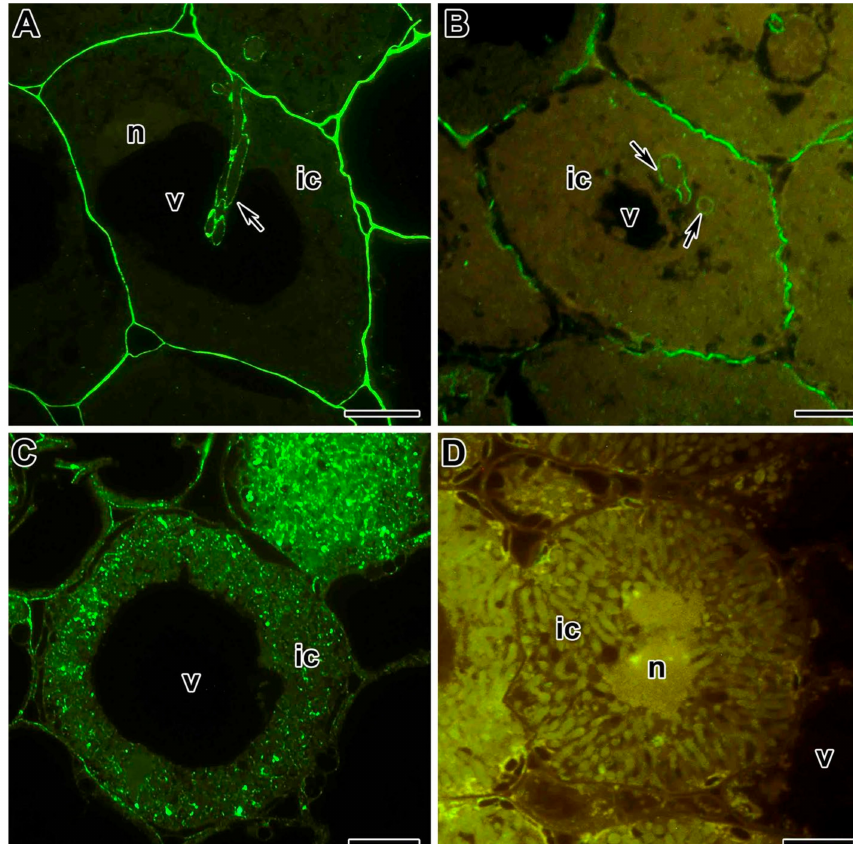
Figure 4. Fluorescent immunolocalization of di ff erent epitops of cell wall and plasma membrane components in the wild-type nodules of P. sativum and Medicago truncatula . The secondary antibody used was goat anti-rat IgG MAb conjugated with Alexa Fluor 488. ( A ) Highly methylesterified homogalacturonan epitope labeled with JIM7 in the nodule from the wild-type line SGE of P. sativum . ( B ) Highly methylesterified homogalacturonan epitope labeled with JIM7 in the nodule from wild-type line A17 of M. truncatula . ( C ) Arabinogalactan protein epitope labeled with JIM1 in the nodule